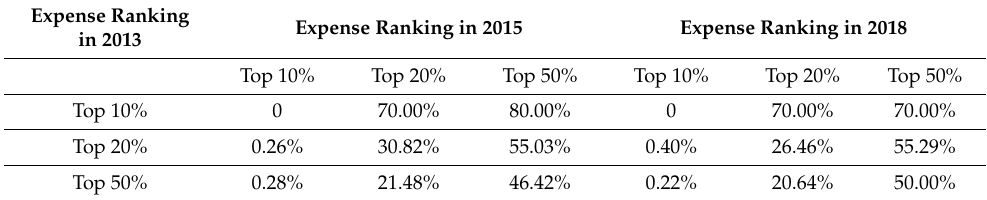
Table 4. Persistence of total medical expenses during 2013, 2015, and